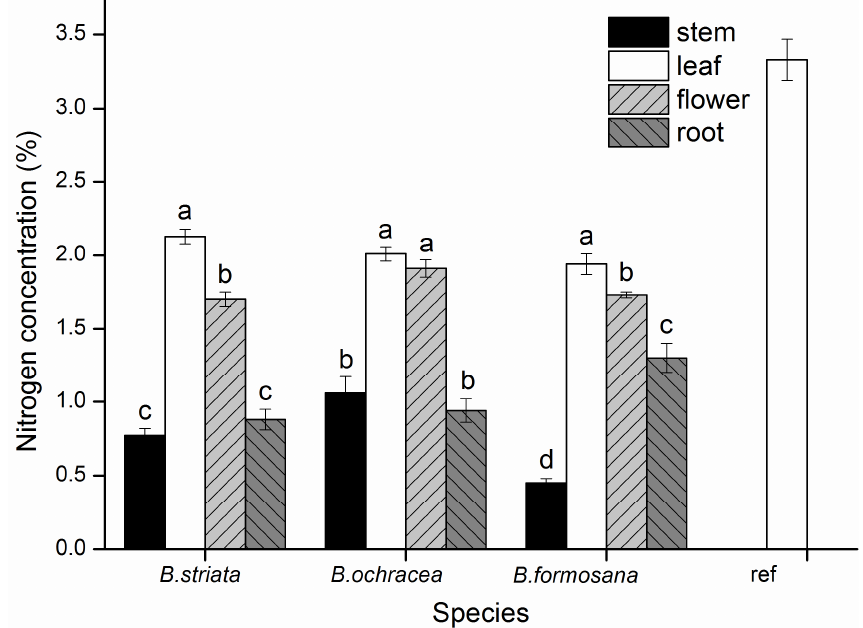
had a higher nitrogen concentration compared with different organs of Bletilla . Nitrogen